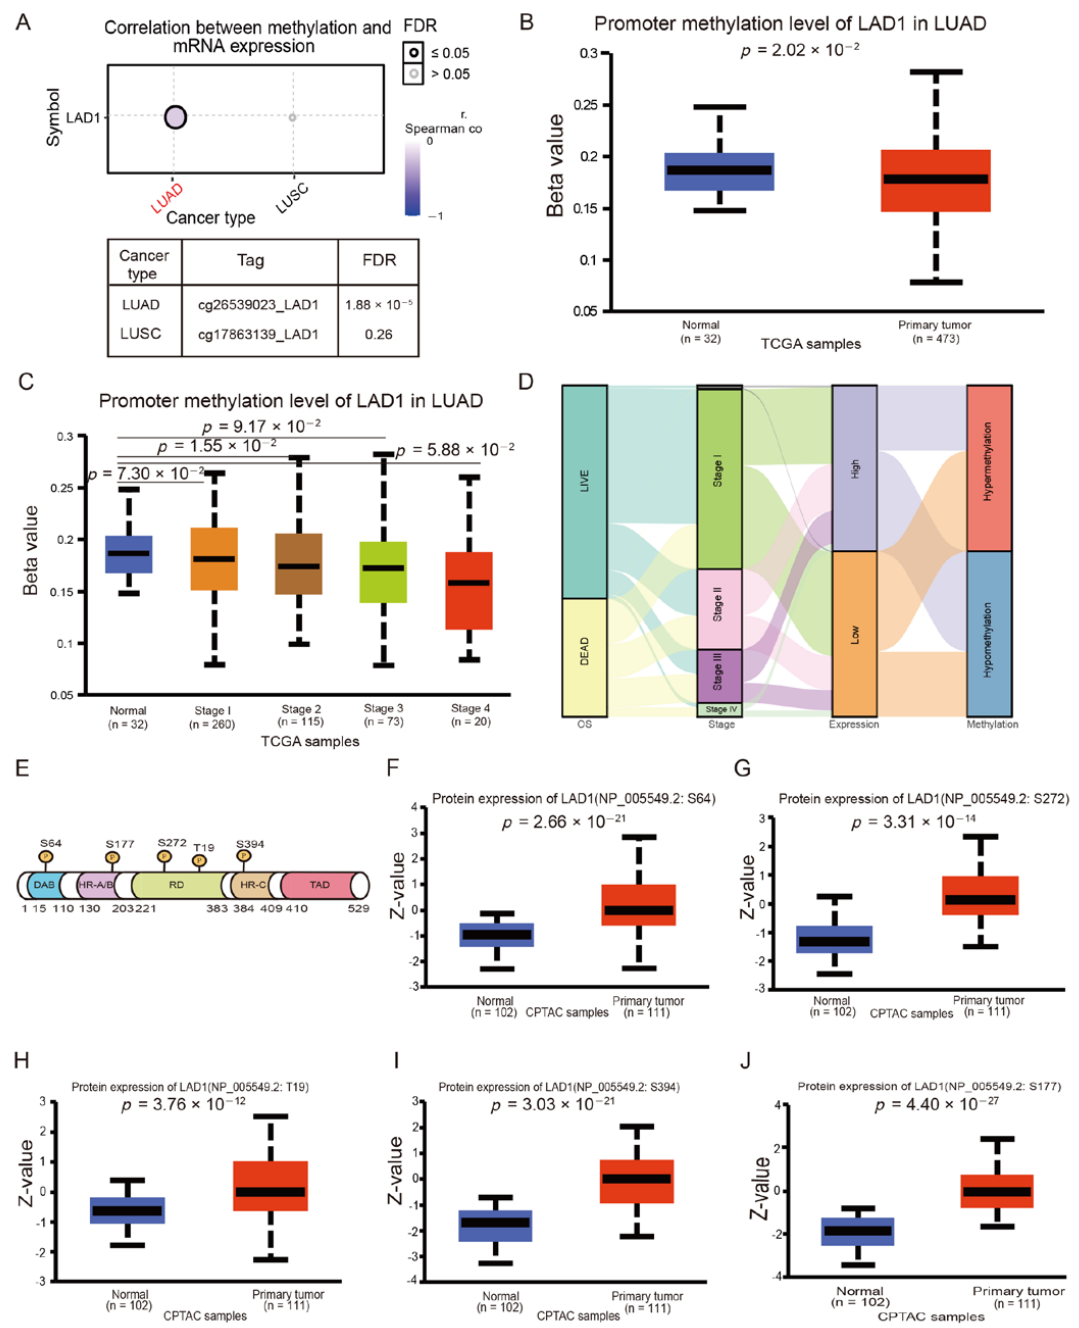
Figure 3. LAD1 exhibits promoter hypomethylation and protein hyperphosphorylation in LUAD. ( A ) The bubble plot shows the correlation between methylation and mRNA LAD1 expression in LUAD and LUSC. The size of the bubble point represents statistical significance. ( B ) The UALCAN database was used to analyze the methylation levels of the LAD1 gene promoter between LUAD tumor and normal samples, and the methylation levels were compared in different pathologic stages ( C ). ( D ) The Sankey diagram shows the relationship between survival status, tumor stage, mRNA expression, and promoter methylation. The path width of the lines represents the number of patients transferred from one state to another. ( E ) Potential phosphorylation modification sites of LAD1 were compared between normal and tumor samples in UALCAN, including S64 ( F ), S272 ( G ), T19 ( H ), S394 ( I ), and S177( J